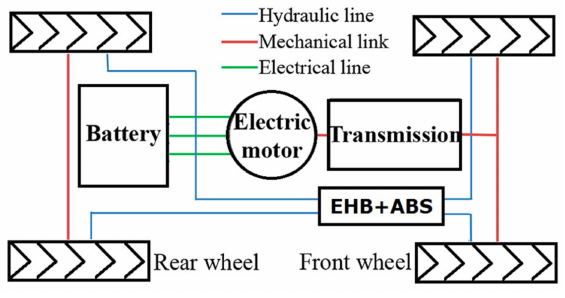
Figure 2. Schematic of the test